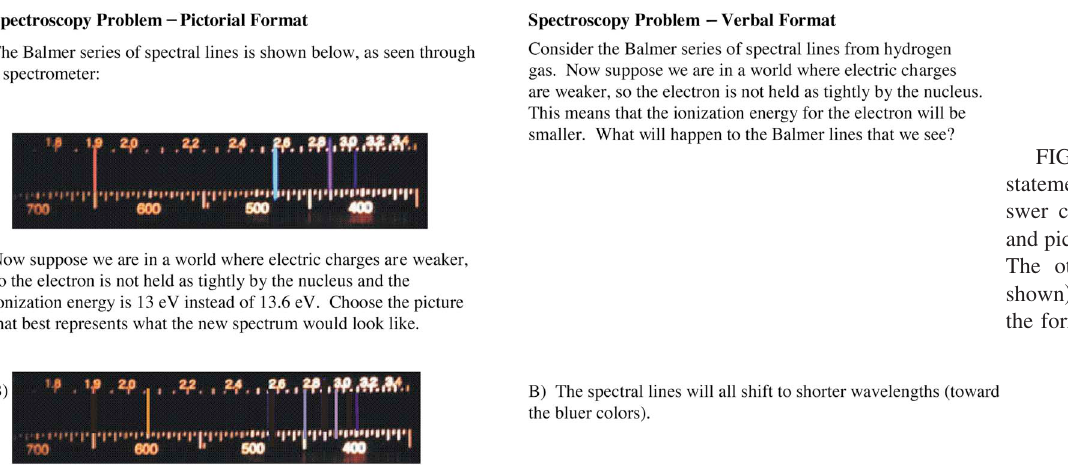
FIG. 2. (cid:1) Color (cid:2) Problem statement and second an- swer choice for the verbal and pictoral format quizzes. The other distractors (cid:1) not shown (cid:2) match up between the formats